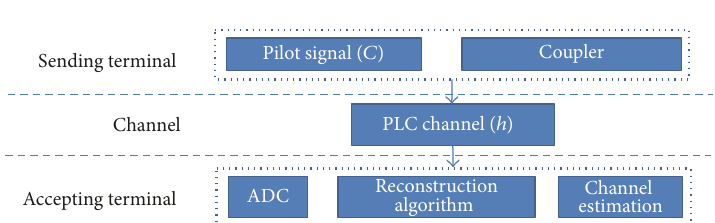
Figure 1: Power line noise.